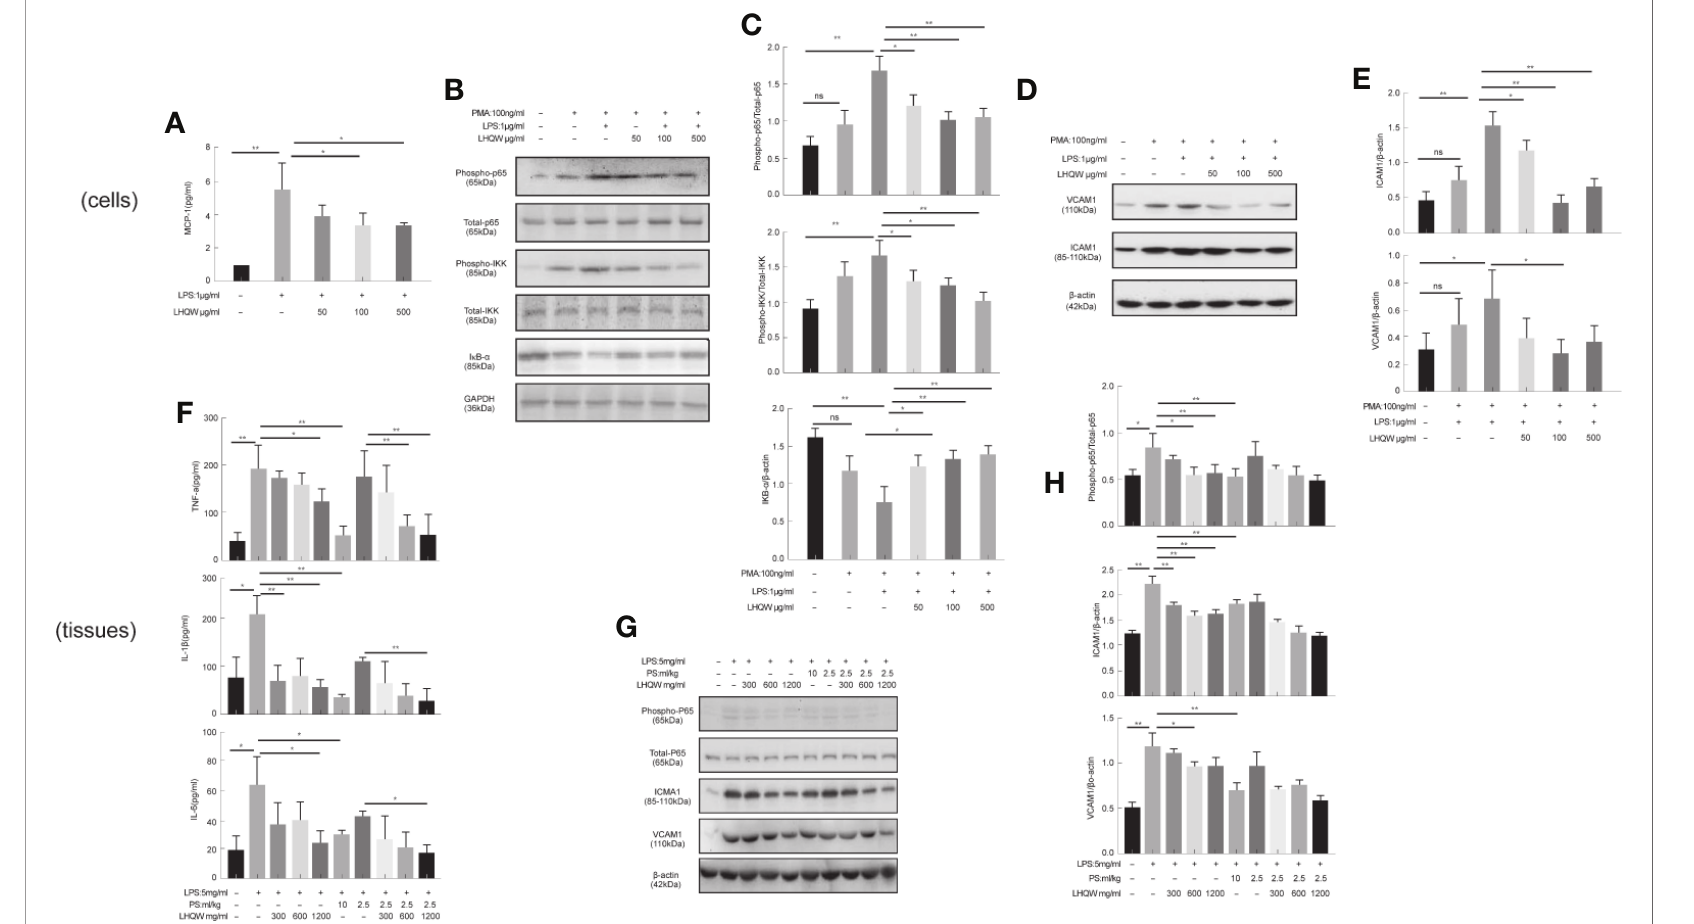
FIGURE 2 | Lian Hua Qing Wen capsule (LHQW) inhibited the expression and secretion of in fl ammatory molecules in macrophages. Mice were dissected 24 h later, the lungs were lavaged with saline, and BALF was collected. (A) Dual luciferase reporter analysis in THP1cells in fl uenced by LHQW. (B, C) Detection of NF- k B pathway-related proteins phospho-p65, total-p65, phosphorylation-IKK, total-IKK, and IKB- a in THP1 cells. (D, E) Determination of adhesion molecules VCAM1 and ICAM1 by western blot assay. (F) LHQW decreased the secretion of TNF- a , IL-1B, and IL-6 measured by ELISA. (G, H) The expression of VCAM1, ICAM1, phospho-p65, and total-p65 in alveolar macrophages measured with western blot analysis. The data was presented as the mean ± S.E.M. of three independent experiments. # P < 0.05 vs. the NC group, * P < 0.05, ** P < 0.01 vs. the LPS group. LHQW-L: 50 m g/ml; LHQW-M: 100 m g/ml; LHQW-H: 500 m